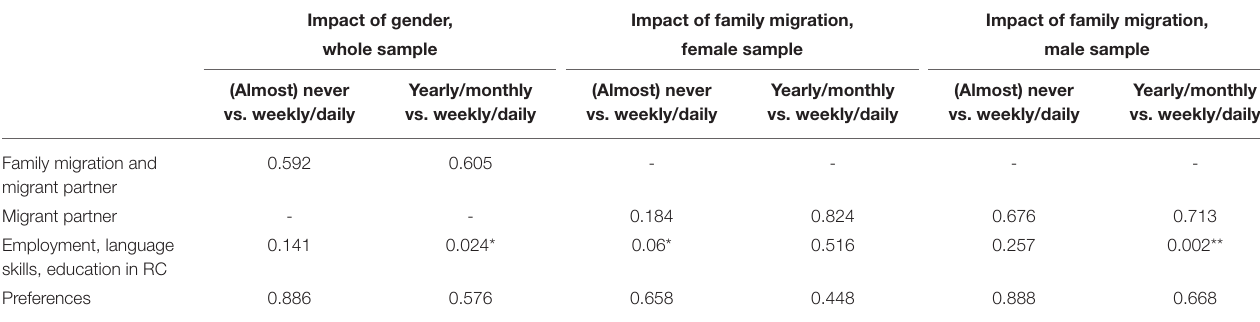
TABLE 6 | KHB Decomposition analysis: Significance ( p -value) of indirect effect of gender (whole sample) and family influence (women and men separately) via mediating variables. Impact of